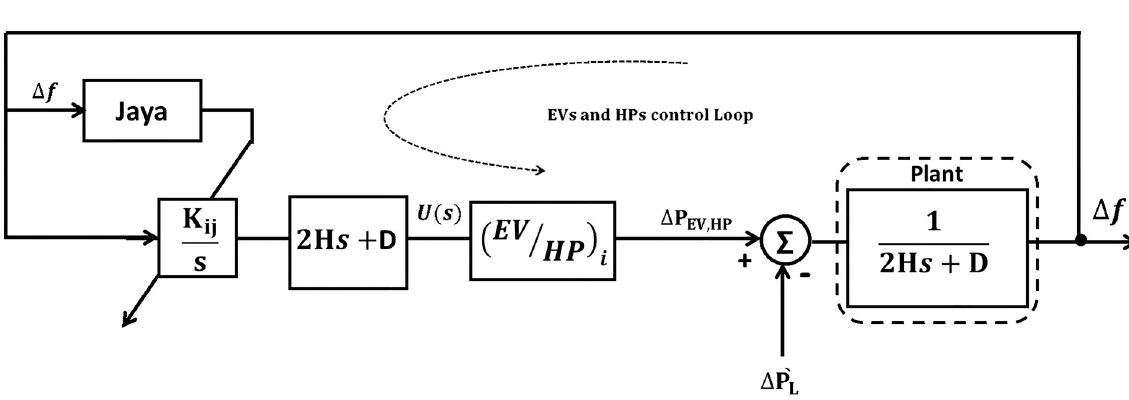
Fig 3. General μ G block diagram with